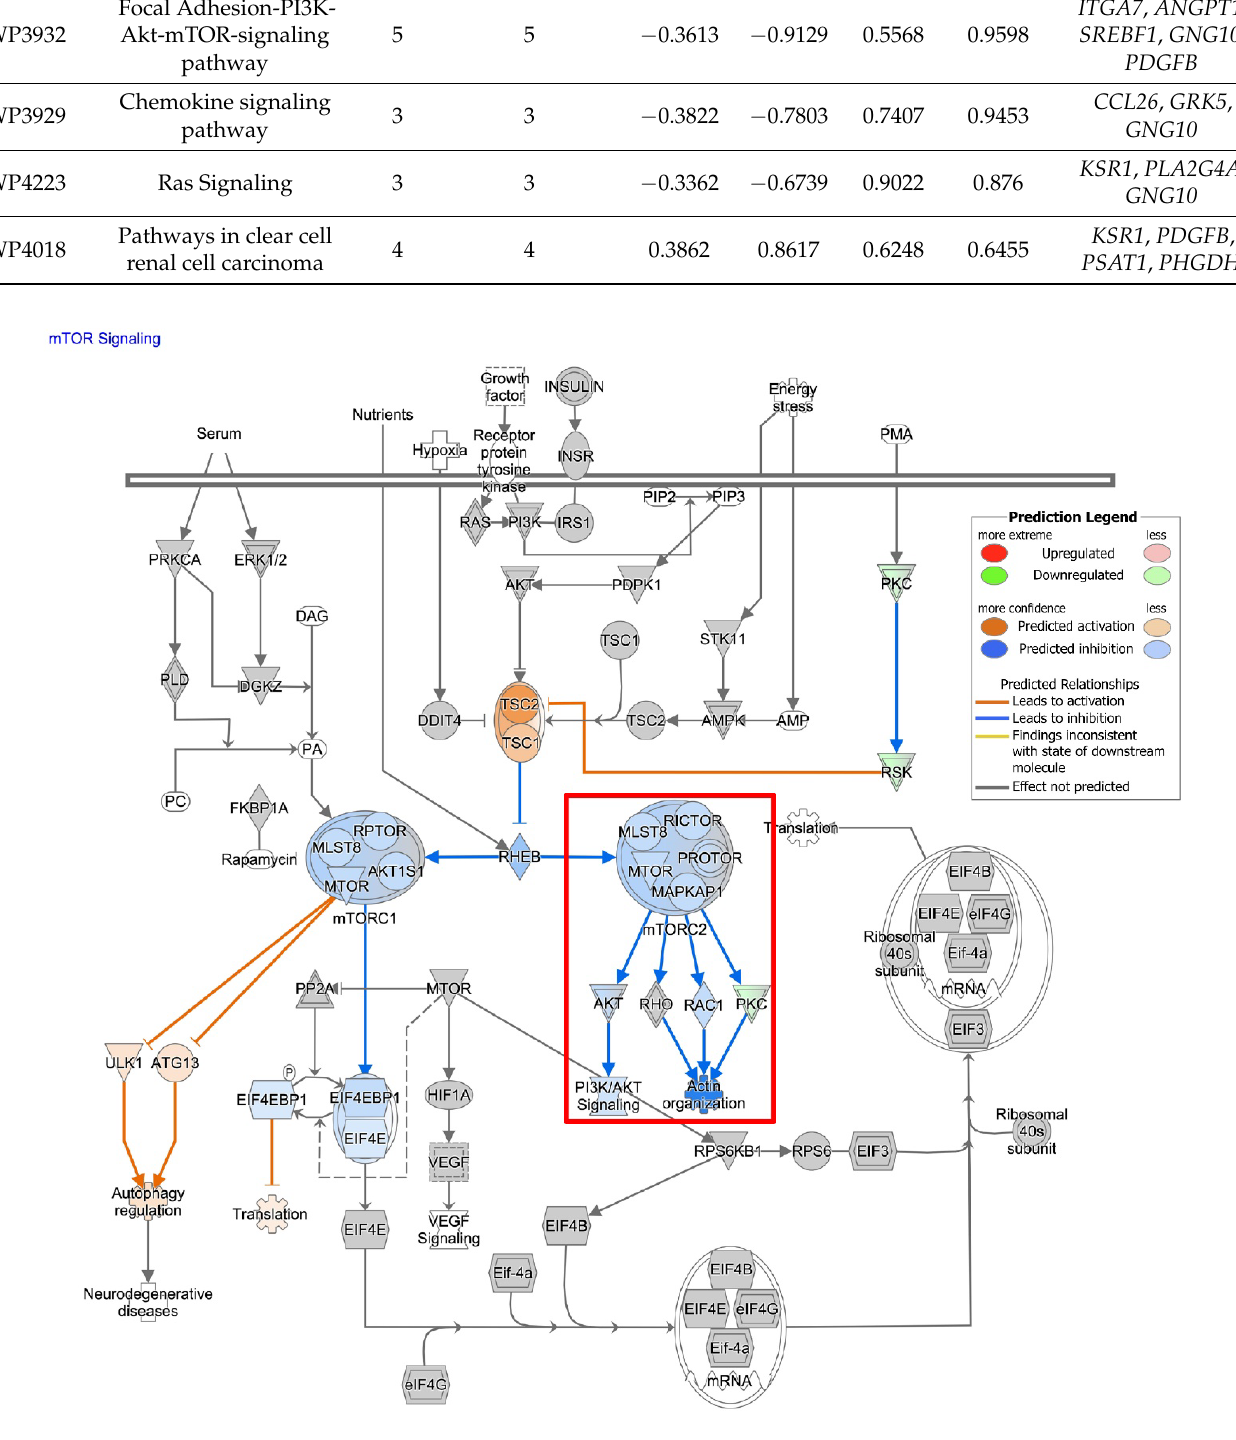
Figure 7. Carmofur treatment affects transcripts associated with mTOR signaling. Qiagen Ingenuity Pathway Analysis (https://digitalinsights.qiagen.com/IPA) (accessed on 18 February 2022) of RNA- sequencing data suggested decreases in mTOR signaling with potential downstream inhibition of PI3K/AKT signaling and Actin organization as highlighted in the red box.